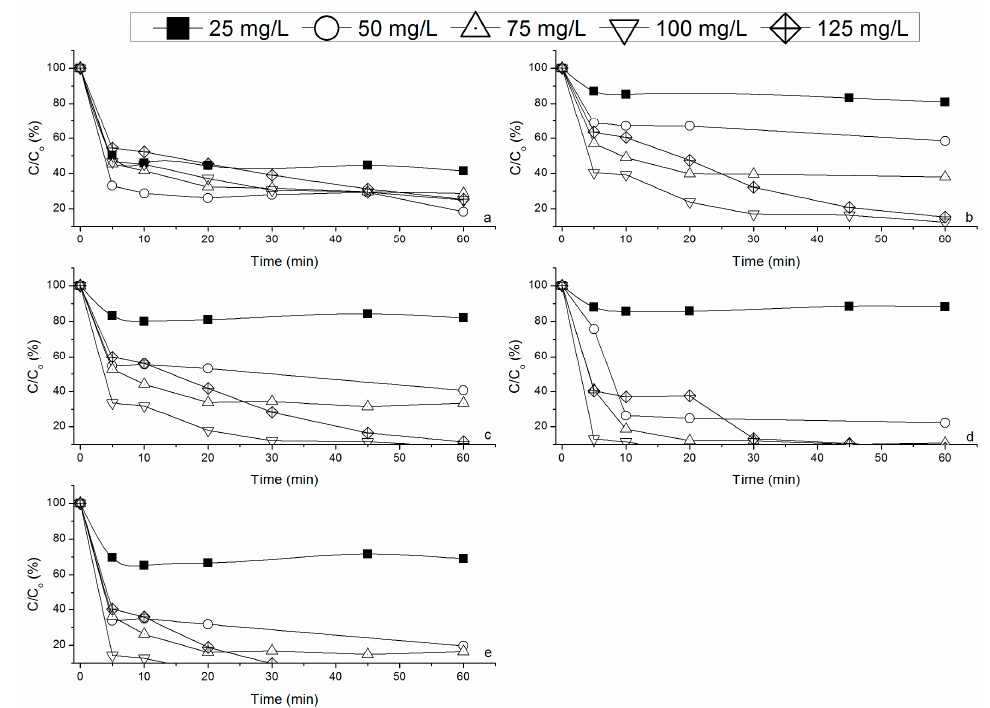
Figure 5. Effect of the concentration of hydrogen peroxide on the degradation of ( a ) 3,4- dihydroxybenzoic acids, ( b ) 4-hydroxybenzoic acid, ( c ) 3,4-dimethoxybenzoic acid, ( d ) 3,4,5- trimethoxybenzoic acid and ( e ) cinnamic acid. (RM = 1 g/L; pH =